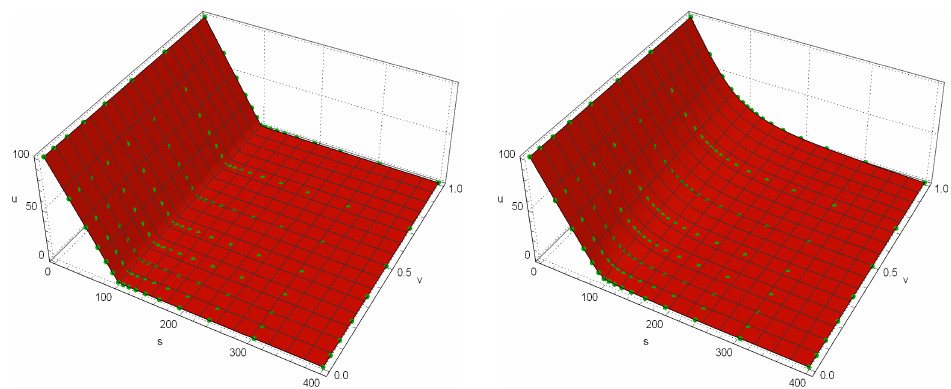
Figure 1. Numerical solution of Example 2 using the RBF-FD-PM solver when τ = 0 on the left and τ = 0.5 on the right. Green points show the location of the graded discretization points on the red curve, which is the numerical